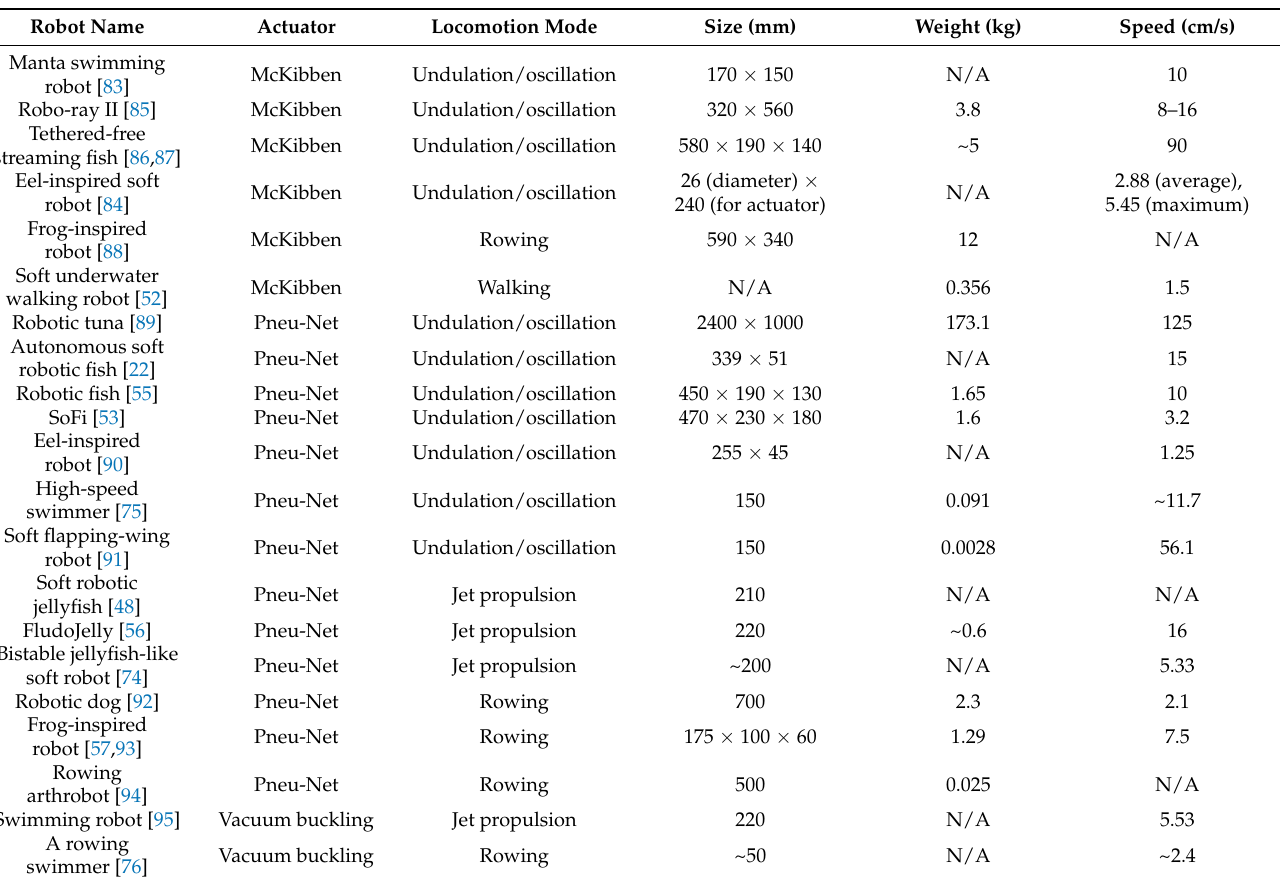
Table 2. Fluid-driven biomimetic robots and their size, weight, and operation speed (N/A means no available